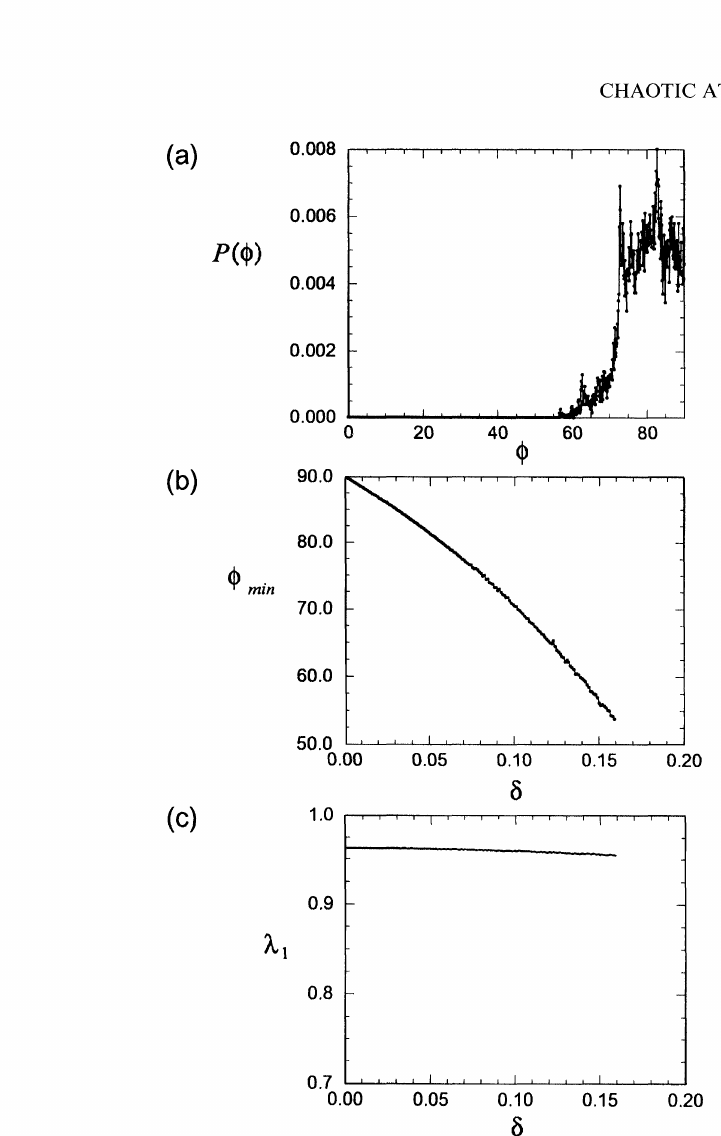
FIGURE 5 Calculation results of the characteristics for the attractor in map (4). (a) A distribution of the probabilities of the angle q5 between stable and unstable manifolds for 6=0.15, (b) a plot of the minimal angle 4min versus param- eter 6 and (c) a dependence of the largest Lyapunov expo- nent on